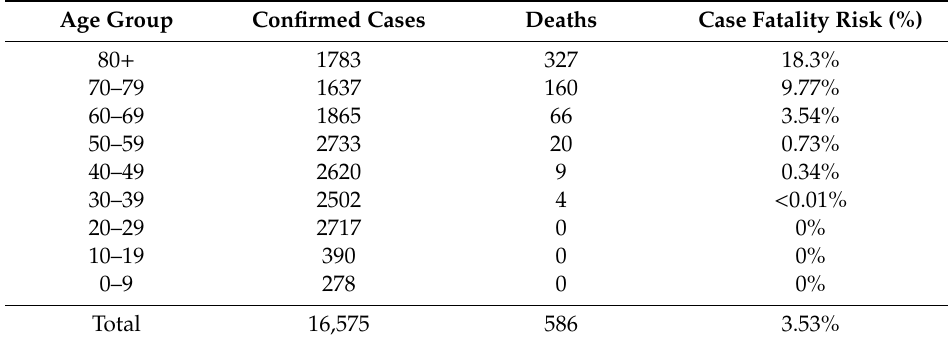
Table 3. COVID-19 cases and deaths in Japan by age group, as of 27 May 2020 (6 p.m.) [75]. Age Group Confirmed Cases Deaths Case Fatality Risk (%)